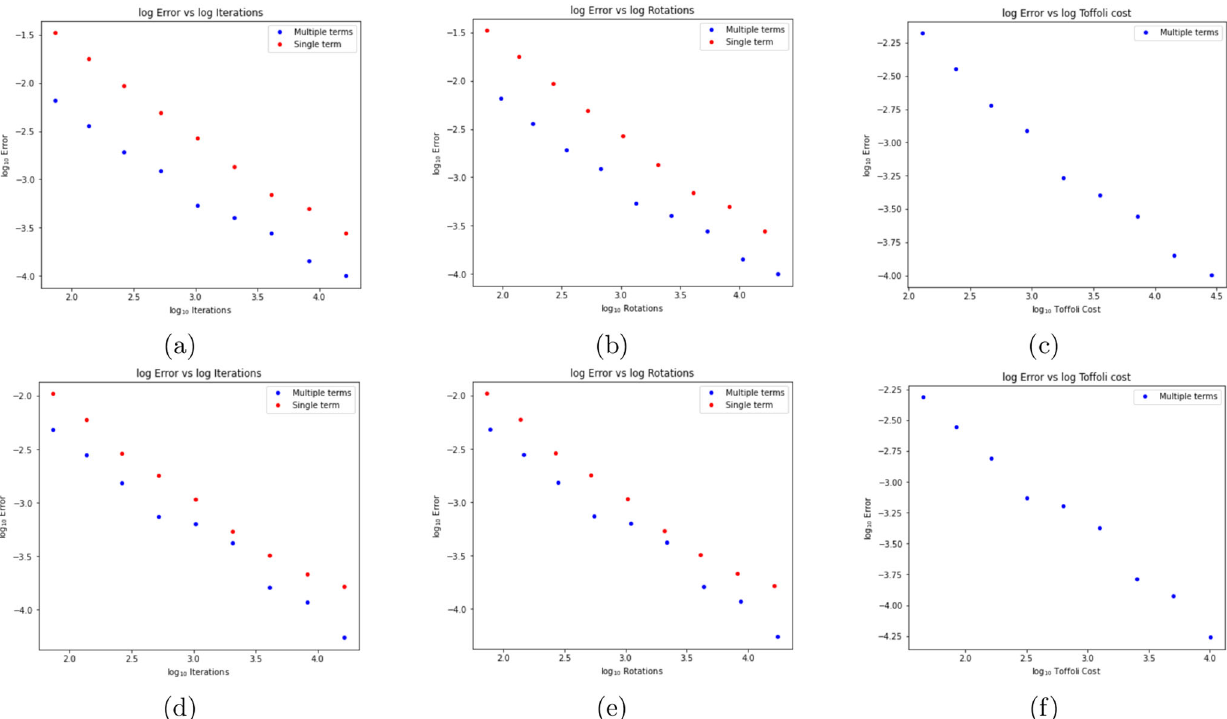
Fig. 8 Simulation of H 2 and LiH Hamiltonian. Log-log plots showing number of iterations ( a , d ), R z / cR z ( b , e ), Toffoli-pairs ( c , f ) as function of error, while simulating the H 2 ( a – c ) and LiH ( d – f ) Hamiltonians with qDRIFT. The red and blue dots show the variation when sampling single and multiple commuting Paulis per qDRIFT iteration, respectively. The Y-axis label in all plots is log Iterations , ( b ), ( e ) is log Rotations and ( c ), ( f ) is log Toffoli Cost log 10 10 10